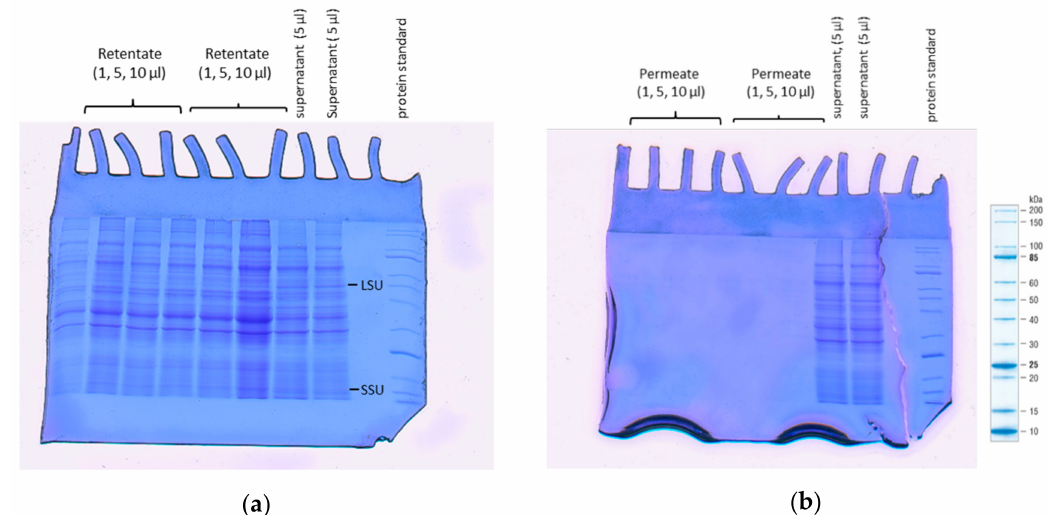
Figure 4. Protein electrophoretic patterns of the supernatant in comparison with ( a ) the retentate and ( b ) the permeate fraction of cassava leaves. RuBisCo large (LSU) and small (SSU)